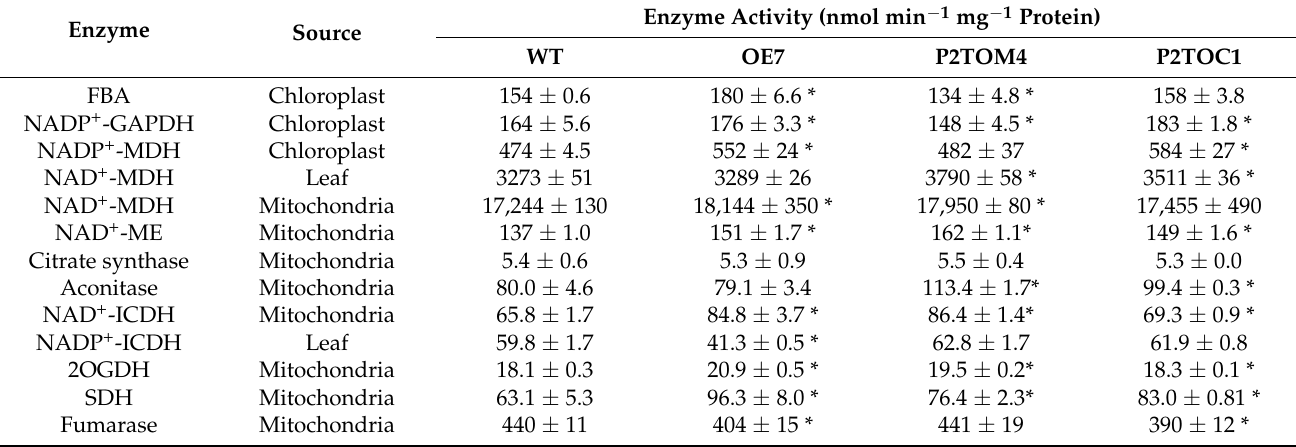
Table 2. Enzyme capacity of CBB and TCA cycles at midday.